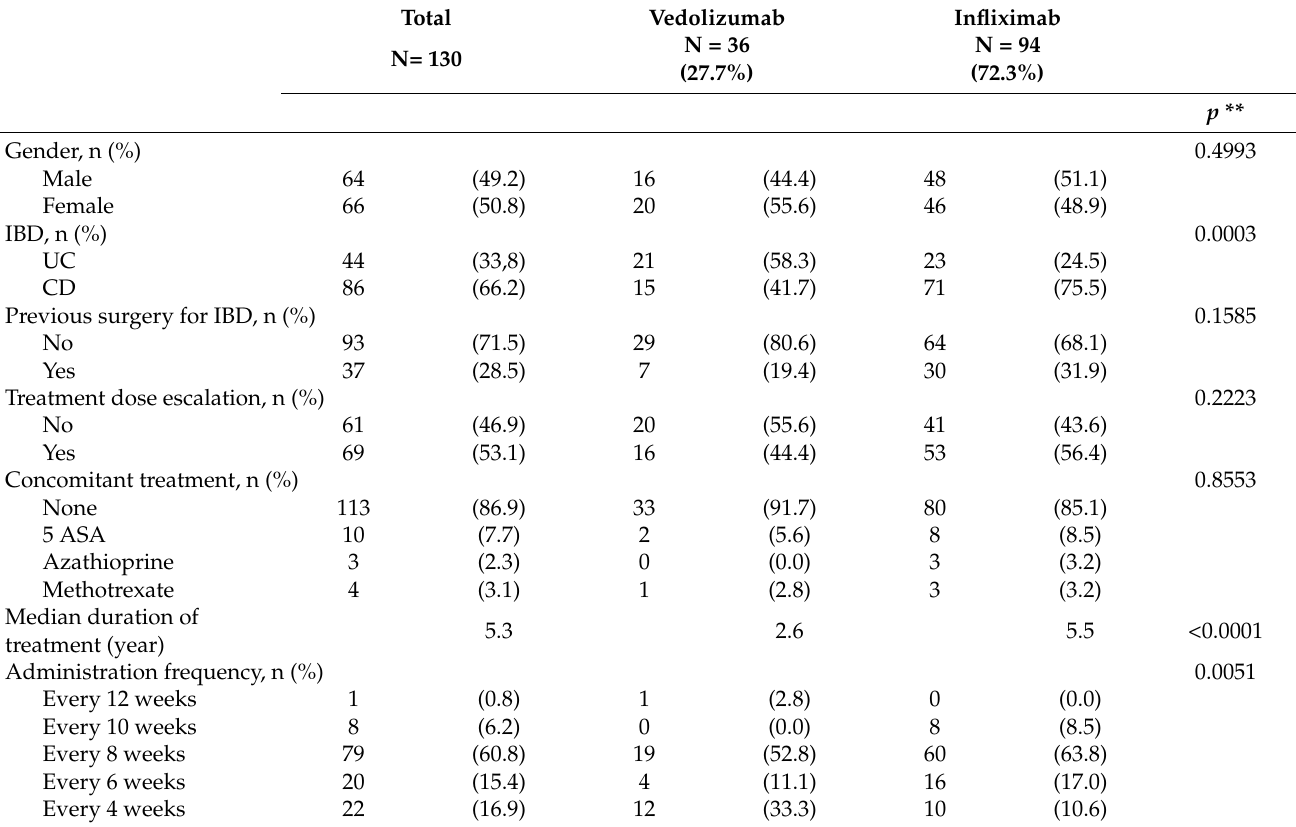
Table 2. Comparison of patient characteristics according to treatment.